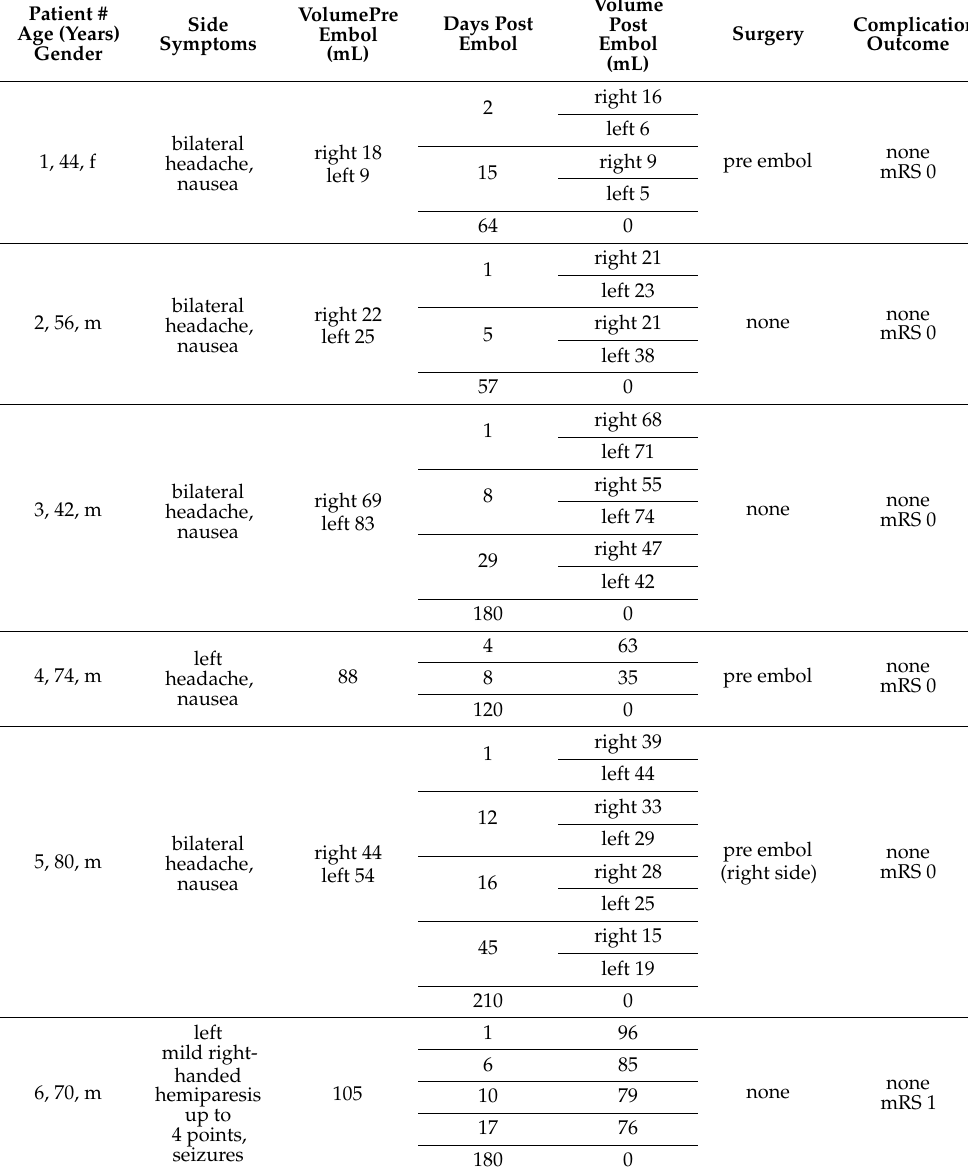
Table 1. Summary of demographic and treatment data of 10 patients with CSDH treated with Squid embolization of the